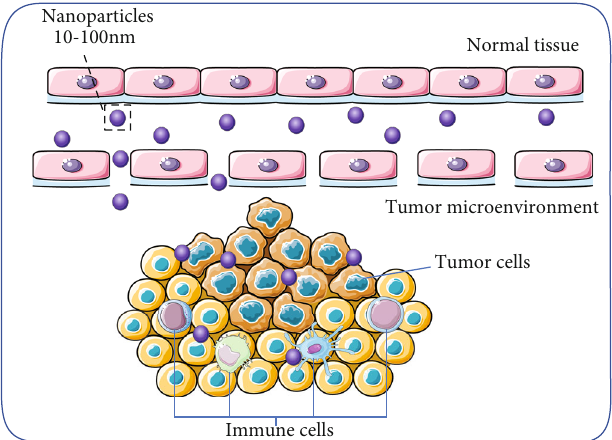
Figure 1: Overview of nanoparticles ’ permeation and retention e ff ect (EPR). Nanoparticles ranging in size from 10 to 100nm are aggregated by EPR e ff ect through the immature blood vessels of the tumor and targeting the cells in the tumor